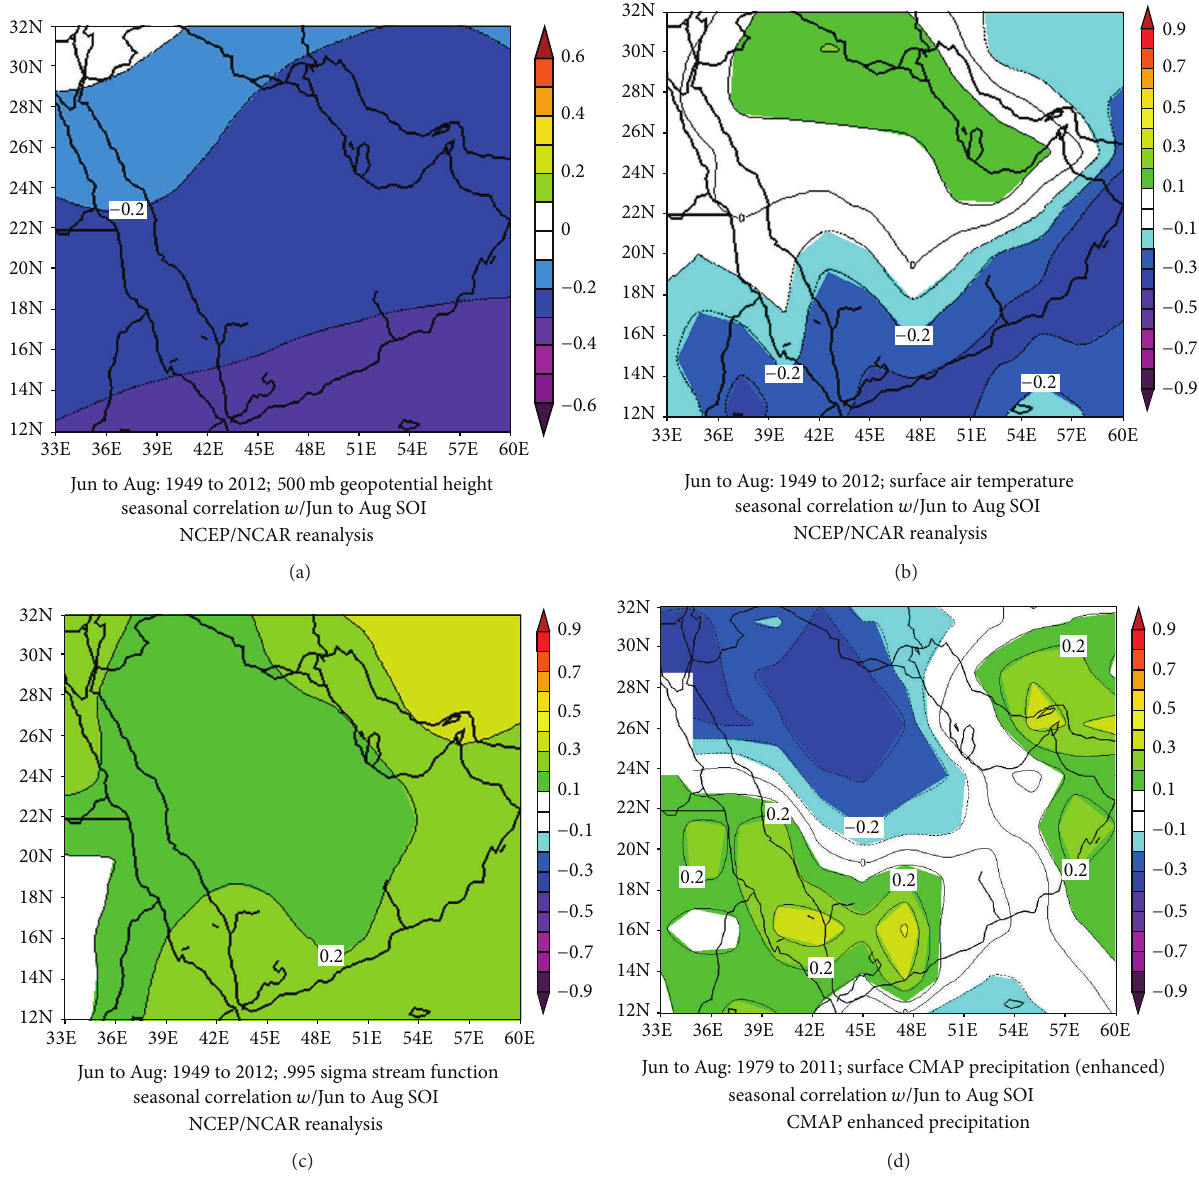
Figure 4: The distribution of linear correlation coefficient between weather elements over KSA and SOI through the period of study.